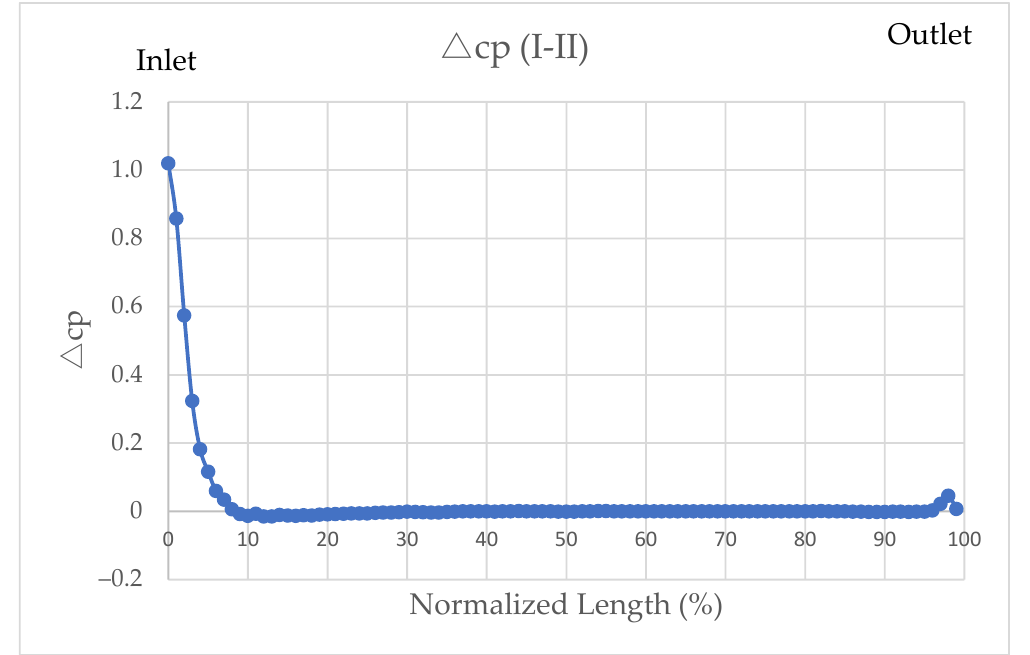
Figure 16. The coefficients of the pressure difference between (I-I) and (II-II).